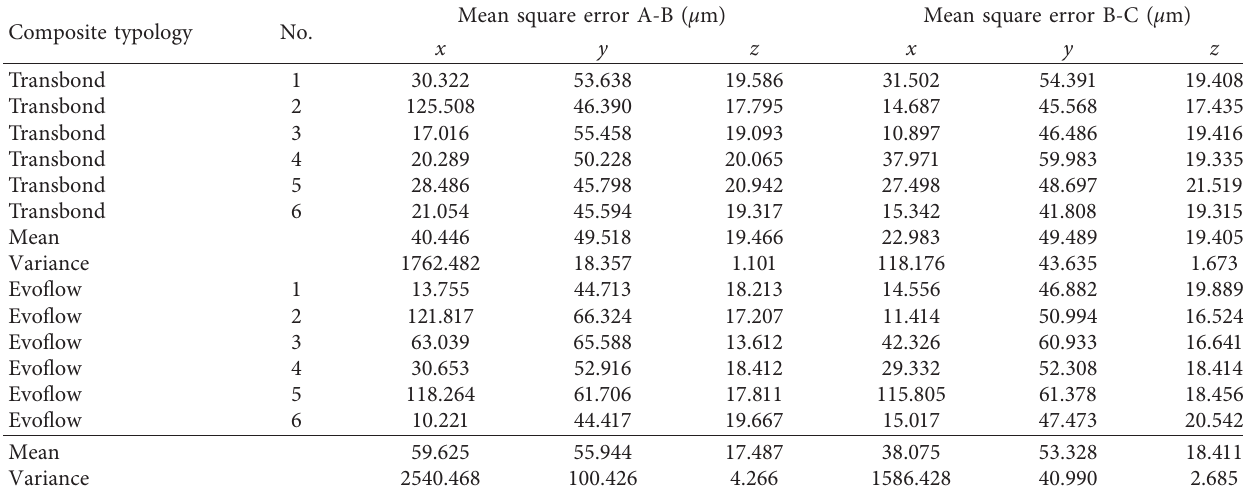
Table 3: Mean square error between the A-B and A-C models realized using the two composite materials, Transbond and Evoflow,